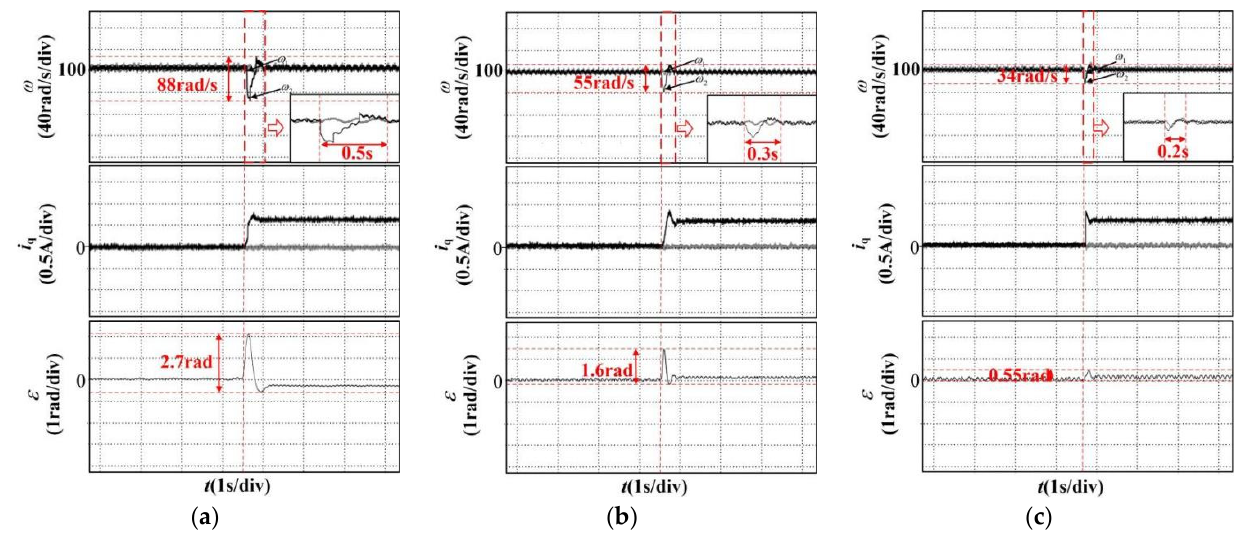
Figure 17. Motor responses when loaded, ( a ) The traditional P-PI-PI control, ( b ) K c = 0, ( c ) K c = 0.5.